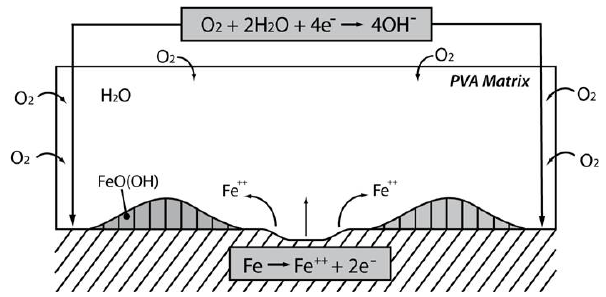
Figure 2. Oxidation of the iron surface in a water-loaded PVA/iron composite